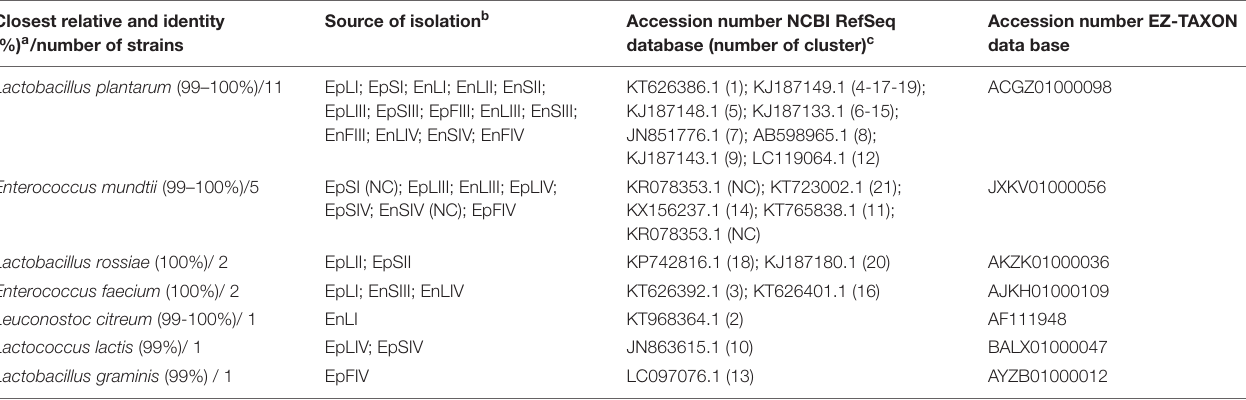
TABLE 1 | Species of epiphytic (Ep) or endophytic (En) lactic acid bacteria isolated from leaves (L), stems (S), and flowers (F) of Origanum vulgare L. plant during the early vegetative (I), late vegetative (II), blooming (III), and full flowering (IV) stages. Accession number EZ-TAXON Closest relative and identity Source of isolation b Accession number NCBI RefSeq (%) a /number of strains database (number of cluster) c data